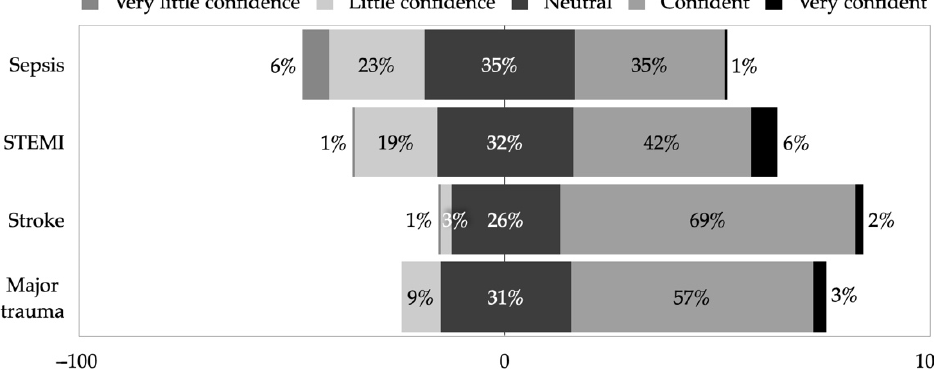
Figure 1. The sources where EMS respondents receive their primary stroke professional continuous